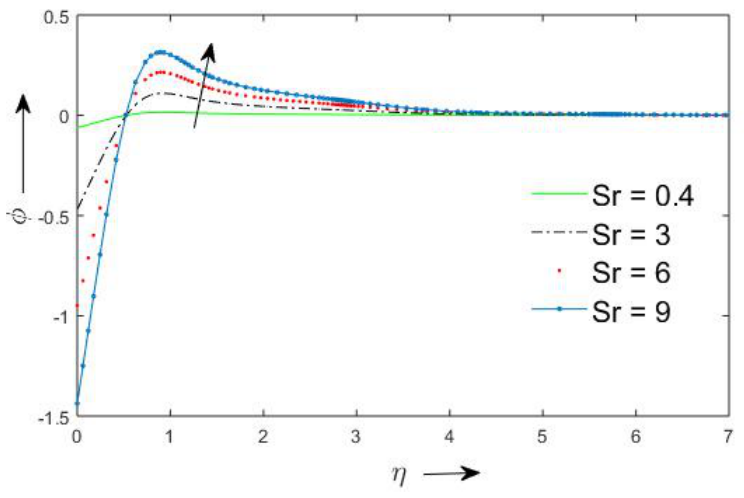
Figure 4: Changes in concentration as a consequence of